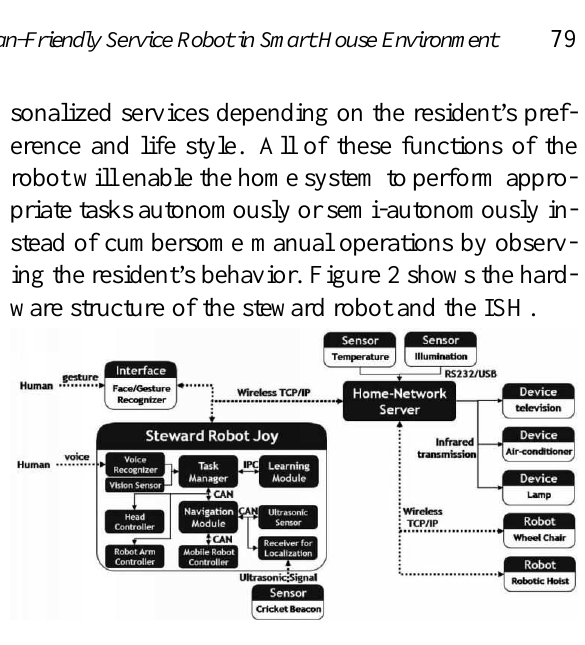
Fig. 2. Structure of the steward robot Joy and the Intelligent Sweet